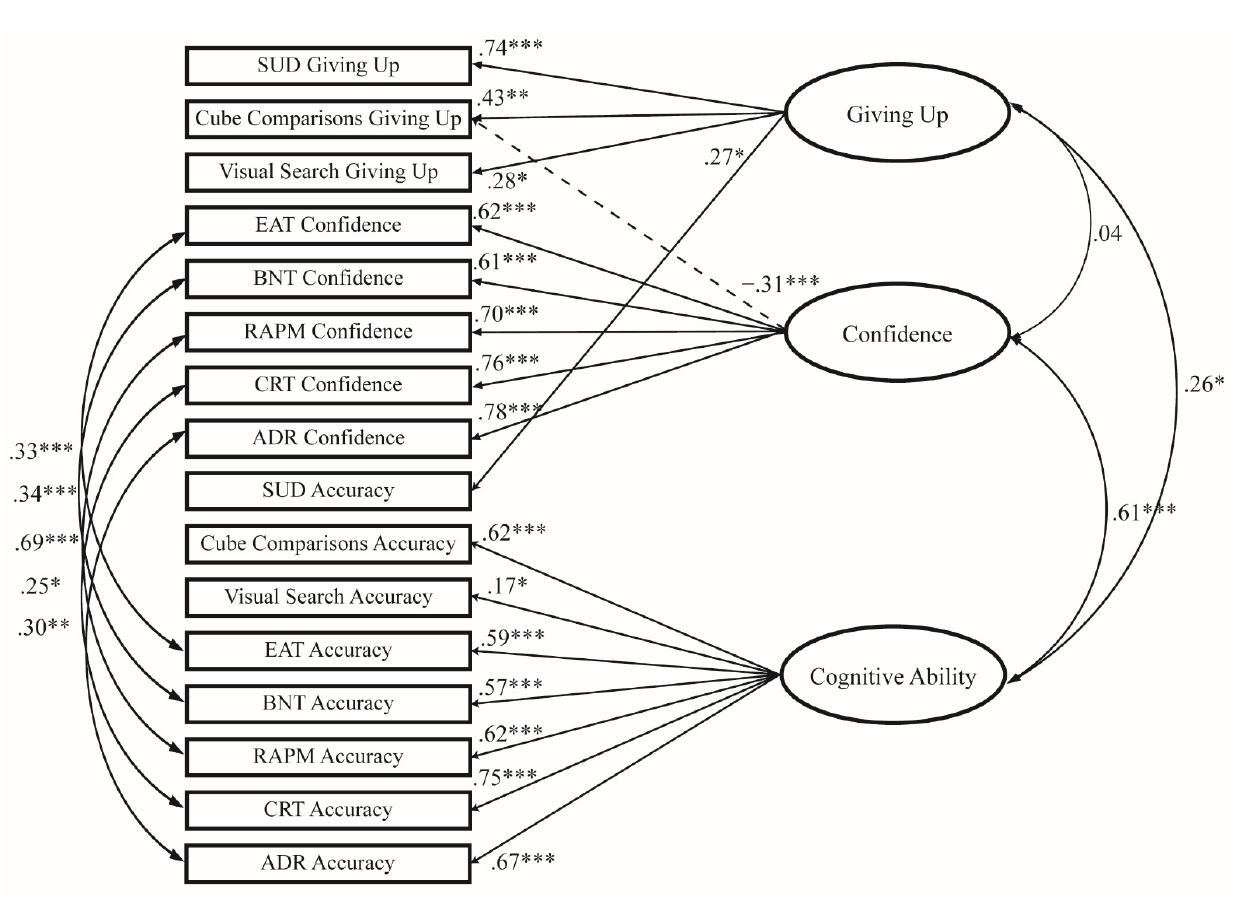
Figure 3. Summary path model of the final three-factor CFA model with standardised regression correlation coefficients * p < .05, ** p < .01, *** p < and correlation coefficients * p < .05, ** p < .01, *** p < .001.